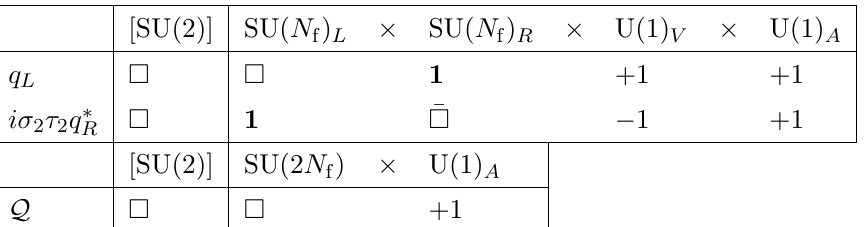
Table 1 . Transformation properties of q L , iσ 2 τ 2 q ∗ Here the new Σ is related to the old one that transforms only under SU(2 N